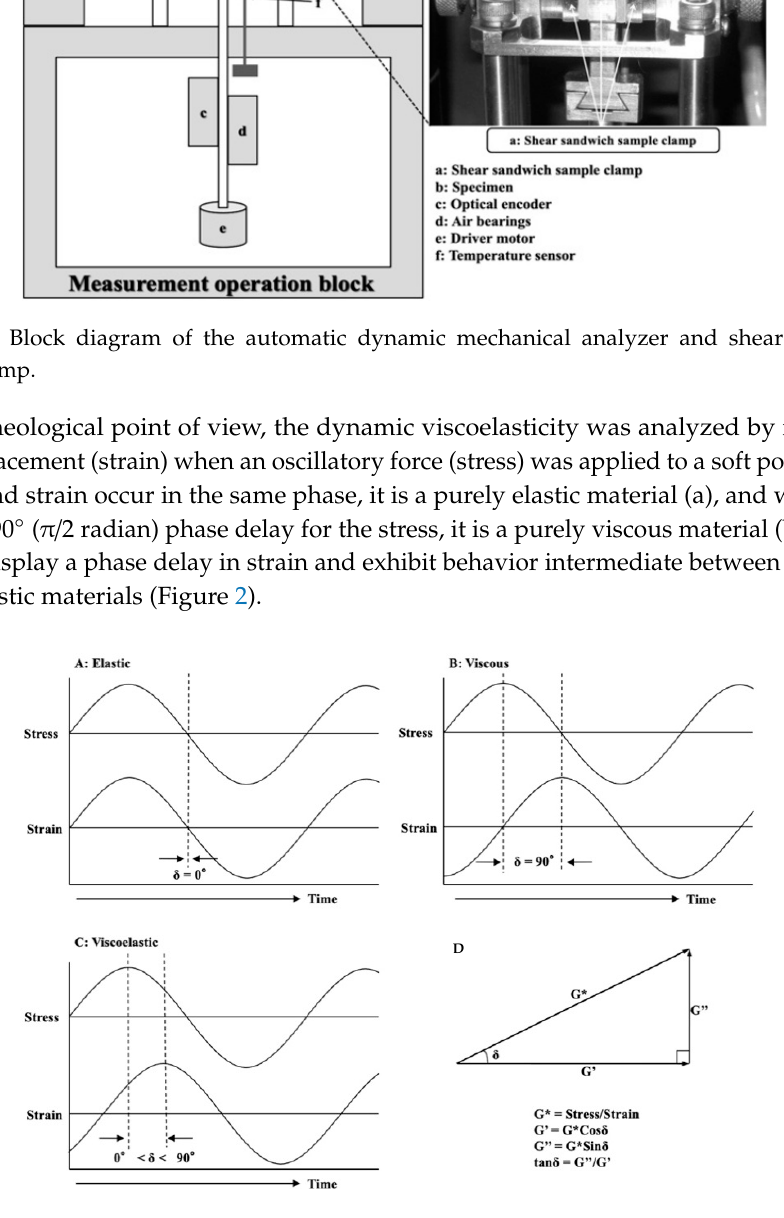
Figure 2. Schematic representation of the relationship between stress and strain. ( A ): Elastic behavior; ( B ): Viscous behavior; ( C ): Viscoelastic behavior; ( D ): Calculation of viscoelastic parameters.